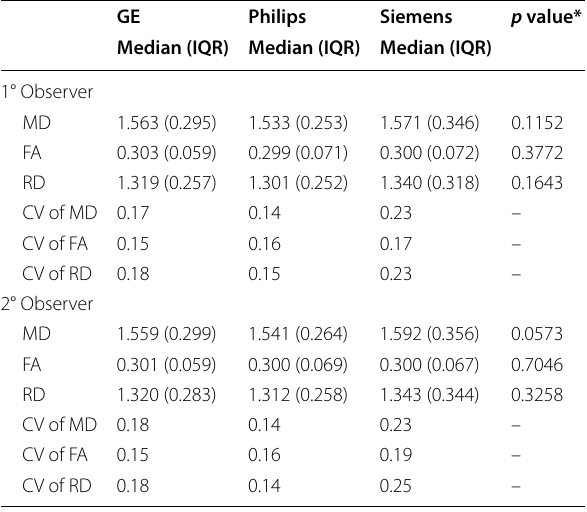
Table 5 Inter-vendor differences in MD, FA, and RD